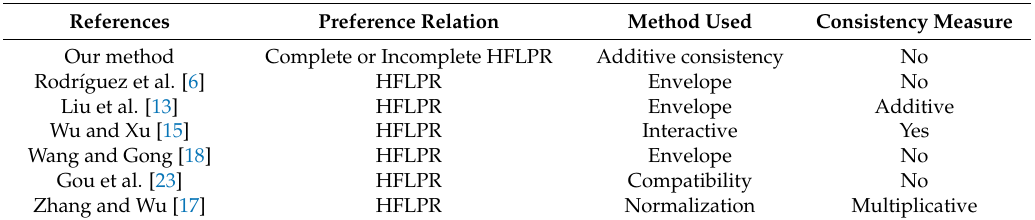
Table 1. Comparison between the proposed model and the other